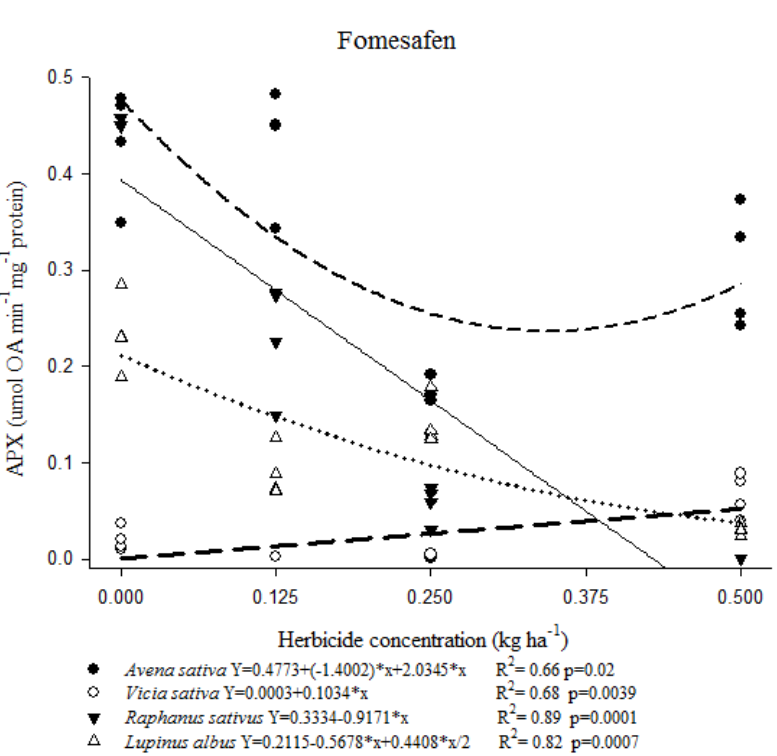
Figure 7 - Effect of fomesafen on Ascorbate peroxidase (APX) activity in different crop plants.